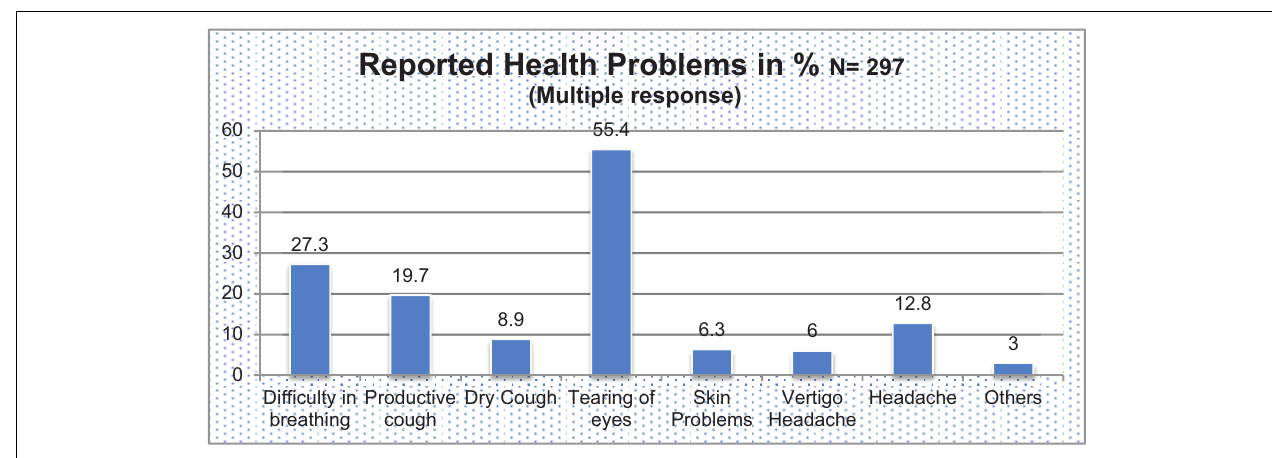
FIGURE 1 | Reported health problems due to indoor air pollution